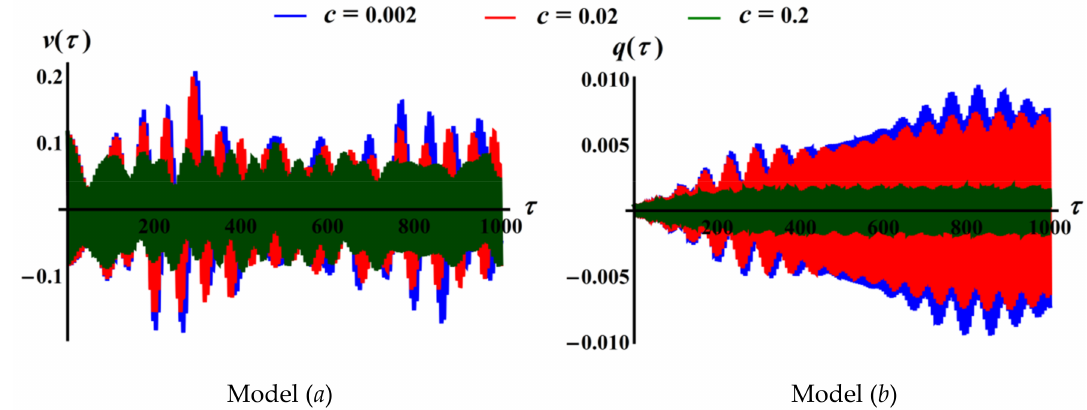
Figure 30. The time histories for the voltage v from the piezoelectric device and the current q from the electromagnetic device with different values of damping coefficient.